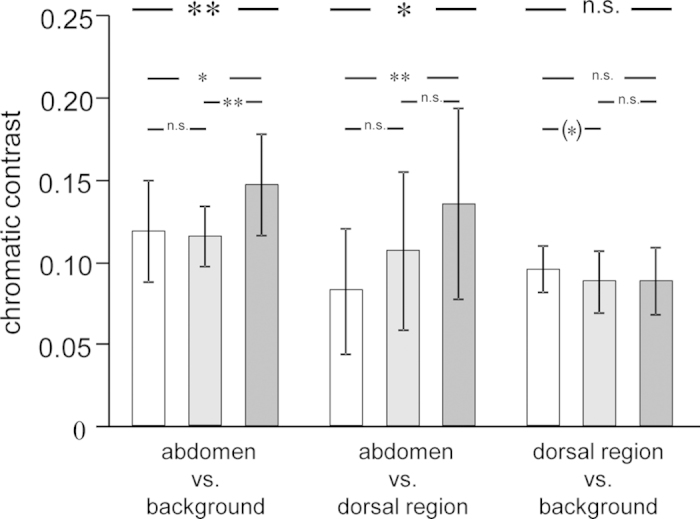
Chromatic contrasts between body regions and background during egg-ripening cycle.Shown are chromatic contrasts (abdomen vs. background, abdomen vs. dorsal region and dorsal region vs. background) of females during the egg-ripening cycle after being stripped (white bars), during the ripening process (light gray bars) and finally when ripe again (dark gray bars). Plotted are means and standard deviations. n.s. p > 0.10; (*): 0.05 < p < 0.10; *p < 0.05; **p < 0.01.